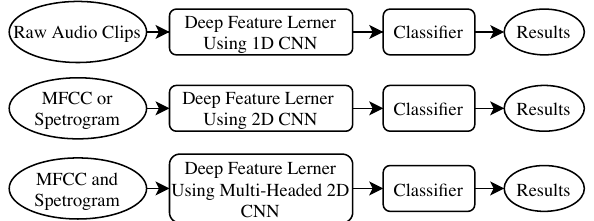
Figure 5. Flow charts of the distress signal recognition approaches adopted in this paper from top to bottom: Classifier using 1D CNN with features extracted from raw data; Classifier using 2D CNN with features extracted from Spectrogram or MFCCs; Classifier using Double 2D CNN with features extracted from Mel spectrogram and